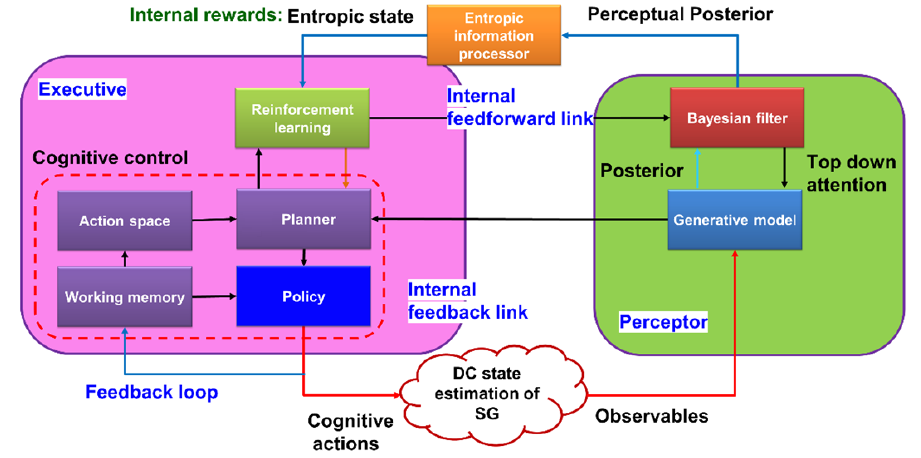
Figure 11. Structure of the CDS for the SG.